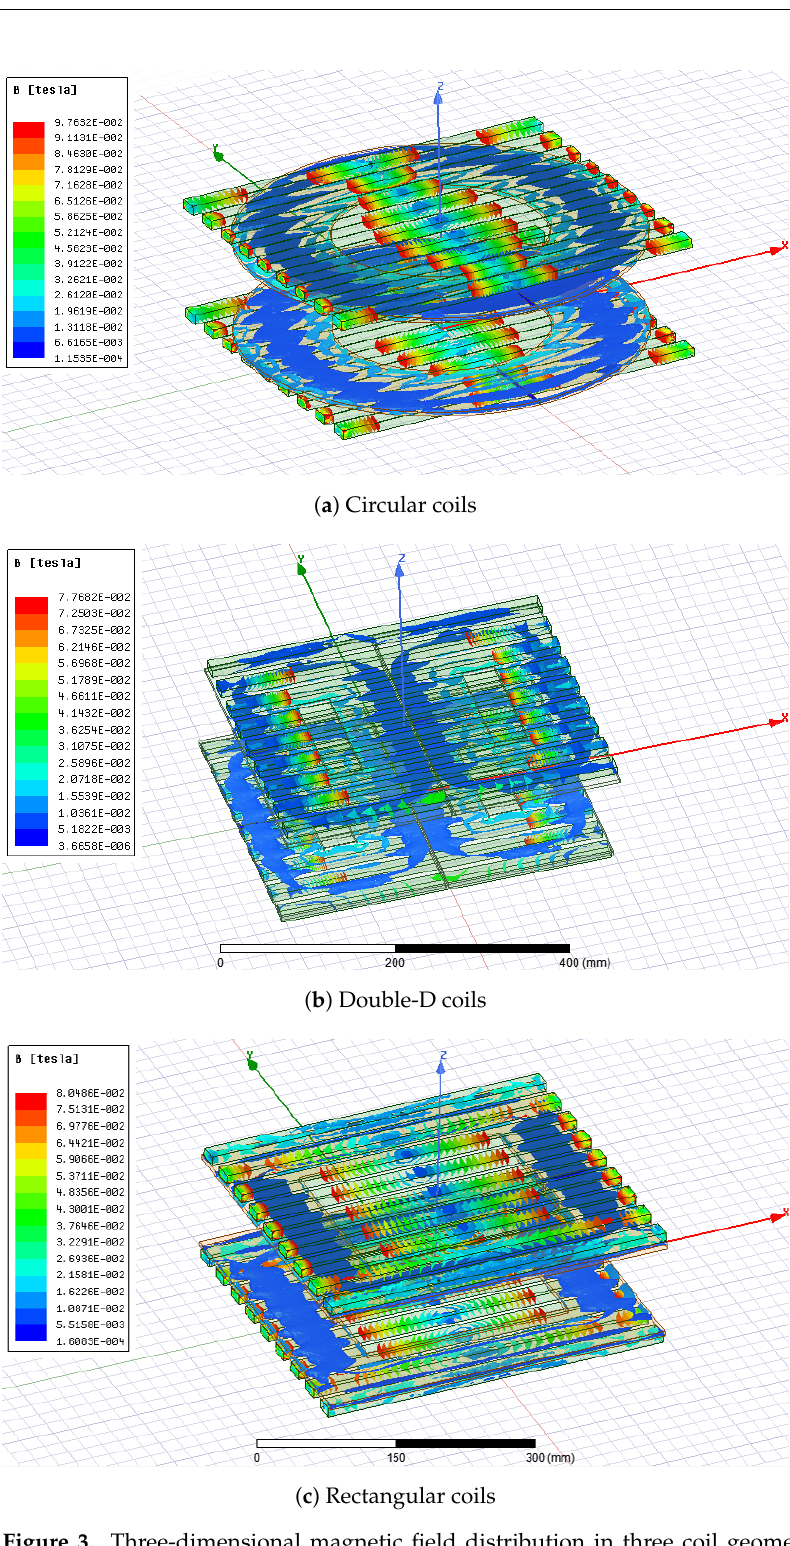
Figure 3. Three-dimensional magnetic field distribution in three coil geometries with 100 mm axial